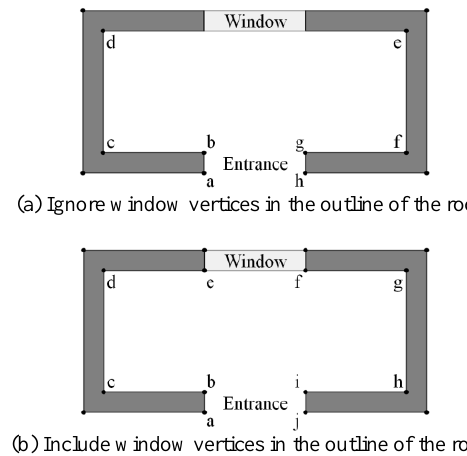
Figure 7. The treatment of windows in the outline of a space The alternative is to include the vertices of the windows in the outline, as shown in figure 7(b). However, the increased